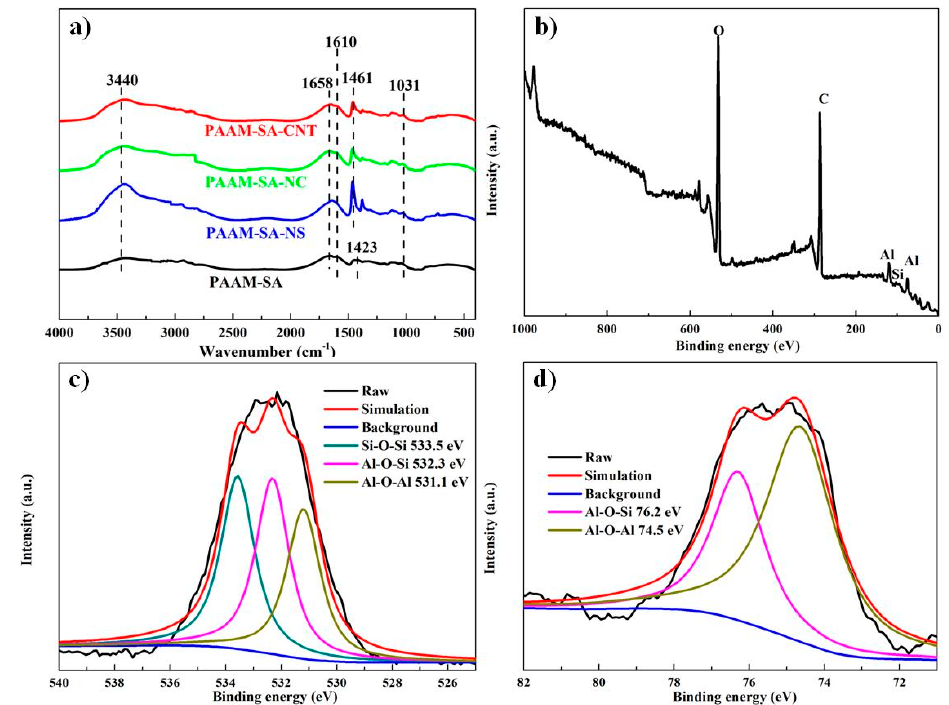
Figure 3. ( a ) FTIR spectra of PAAM-SA, PAAM-SA-CNT, PAAM-SA-NC, PAAM-SA-NS; ( b ) XPS spectrum of nanoclay; XPS spectra of curve-fitted ( c ) O1s and ( d ) Al2p peaks.